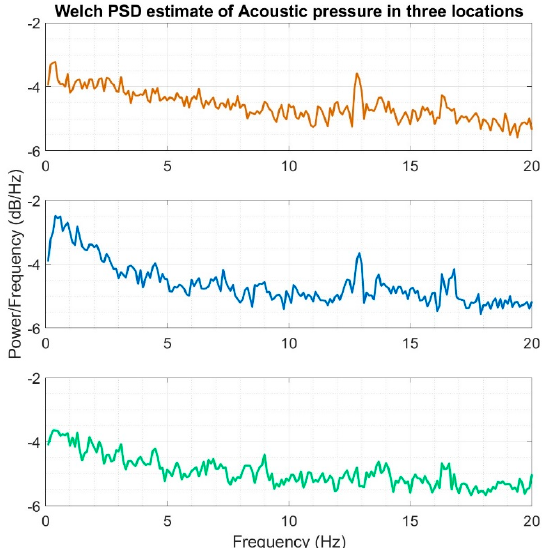
Figure 16. Welch power spectral densities estimated for acoustic pressure acquired in three different locations at the same time: orange color—measuring setup number 1; blue color—measuring setup number 2 and green color—measuring setup number 3.